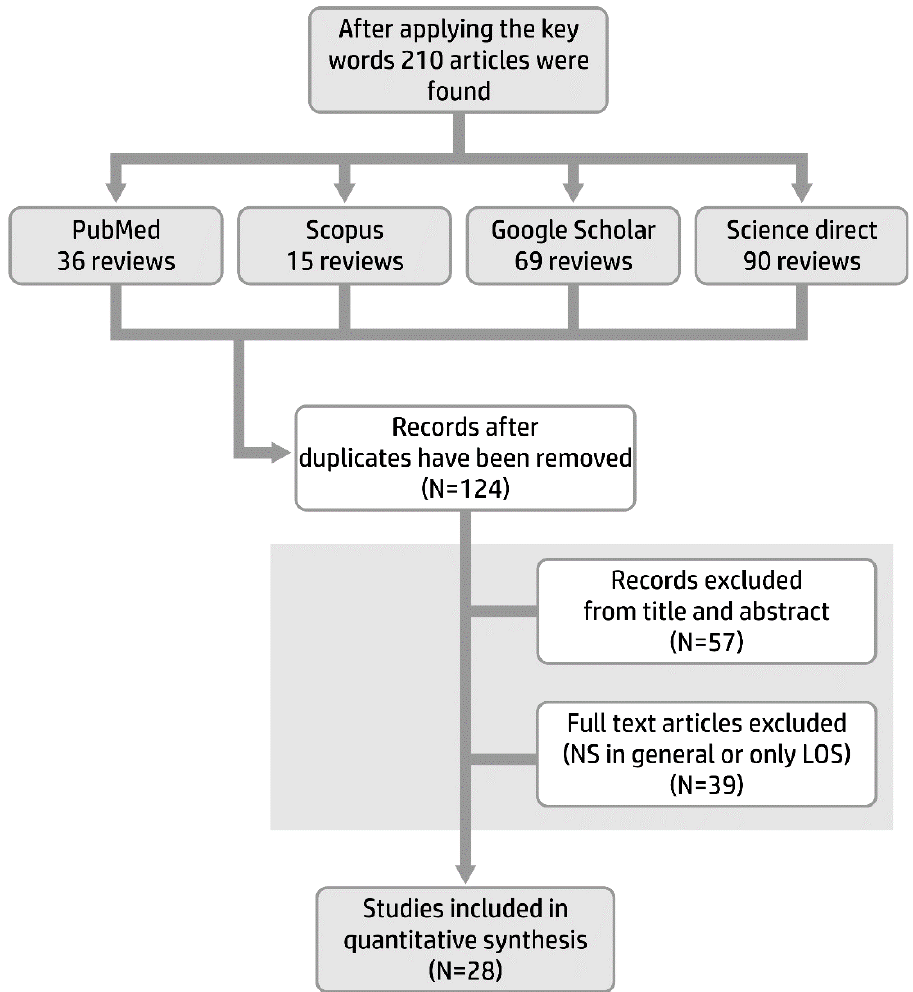
Figure 1. Flowchart of the selection process of the review articles.